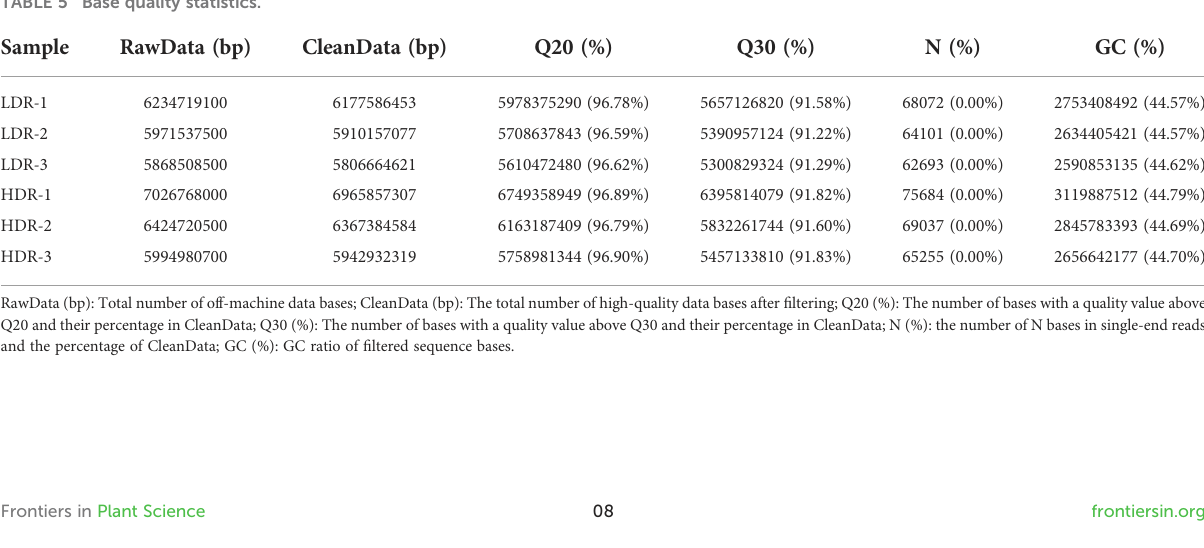
TABLE 5 Base quality